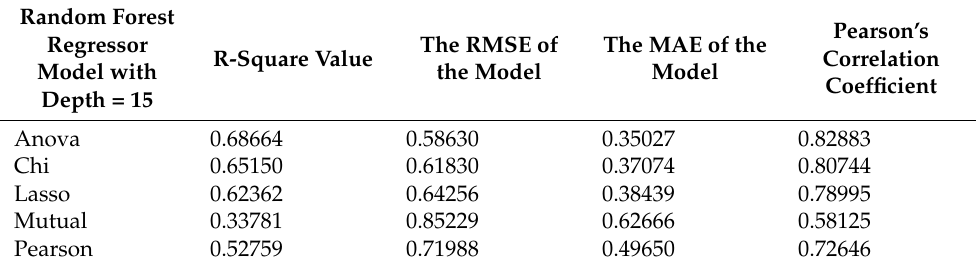
Table 8. Random Forest